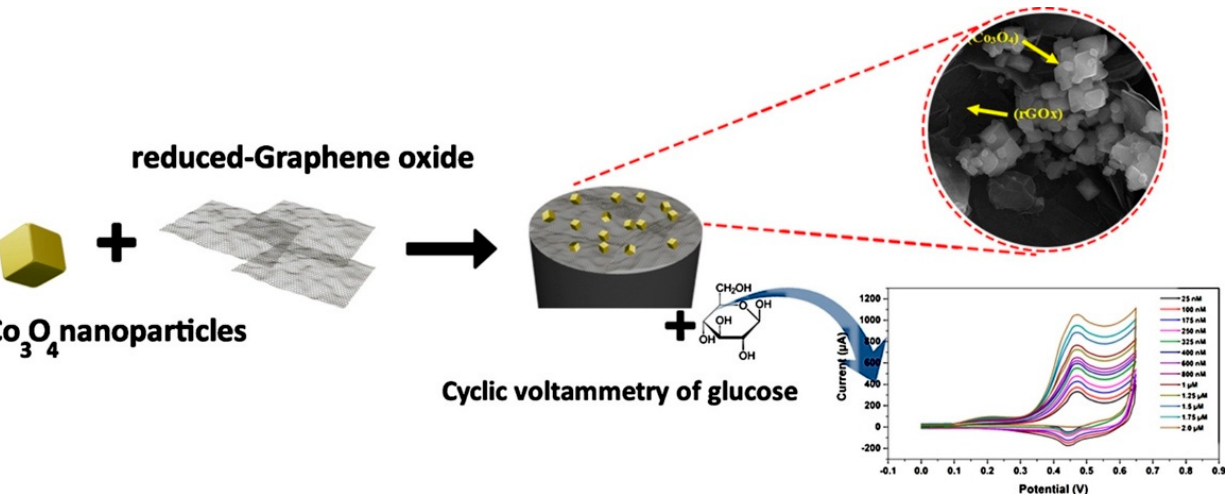
Figure 4. Biosensor for glucose detection based on the electrocatalytic reaction on rGO/Co 3 O 4 nanoparticles-modified glassy carbon electrode [130].